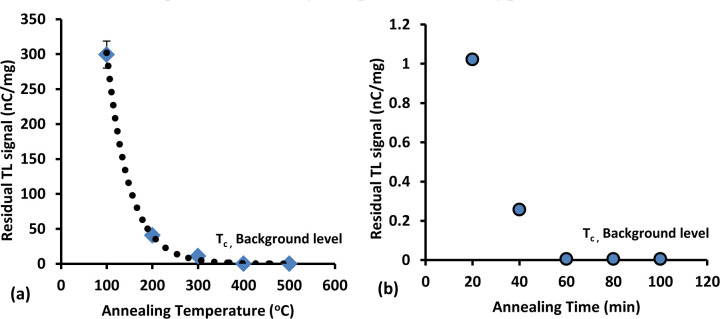
Residual TL signal against (a) annealing temperature and (b) annealing time.